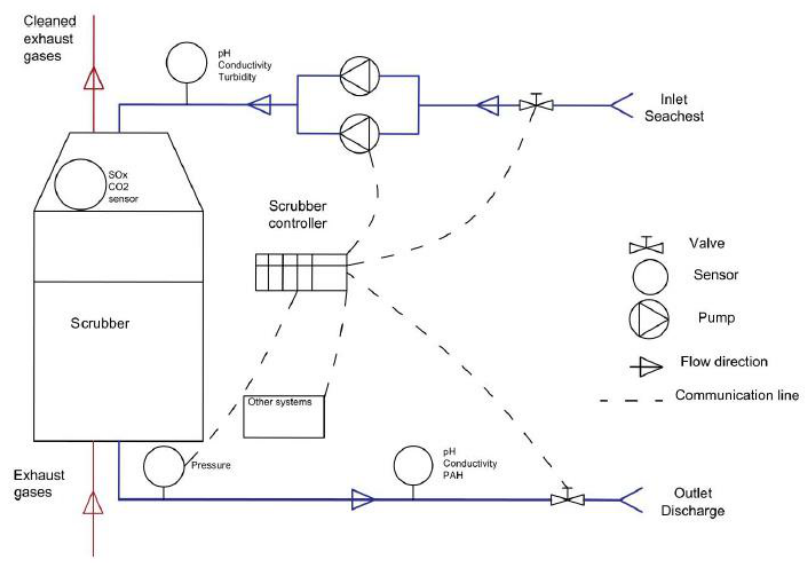
Figure 17. Schematic drawing for an open-loop scrubbing system process. Reprinted from ref. [89].